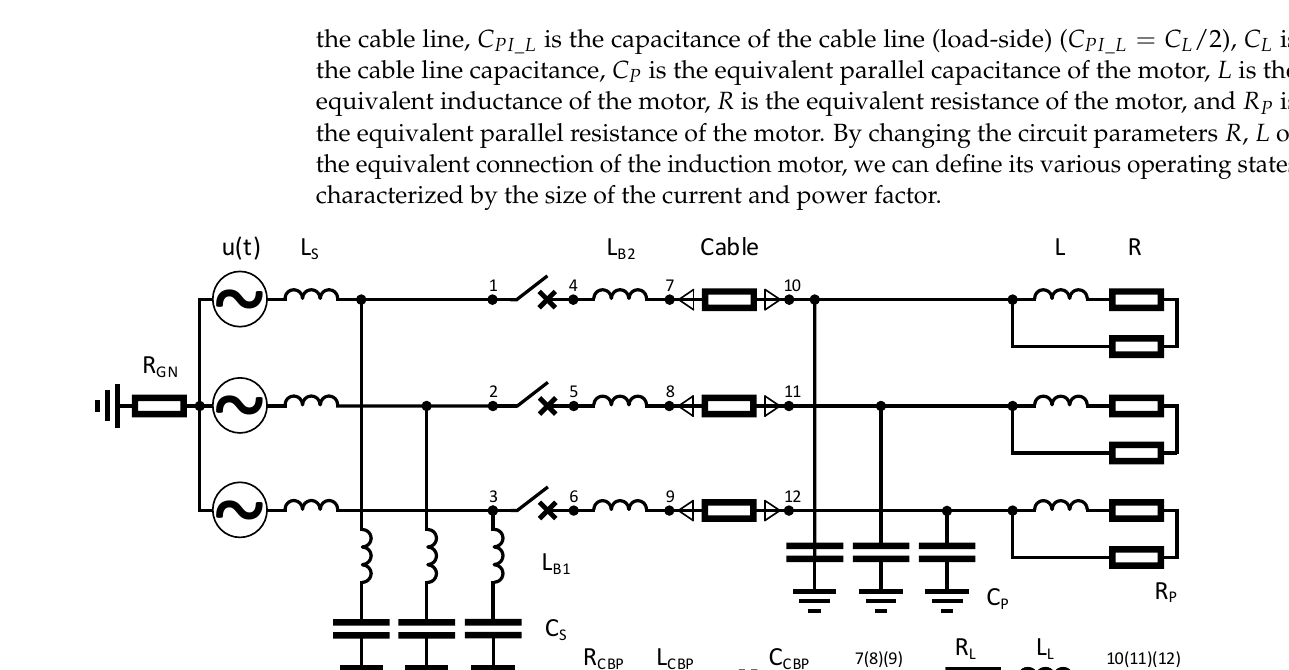
Figure 1. Test circuit for the simulation of switching transients according to IEC 62271-110 ed. 4. Source: [9] and own modification. Numbers refer to the interconnection points among components drawings in Figure.